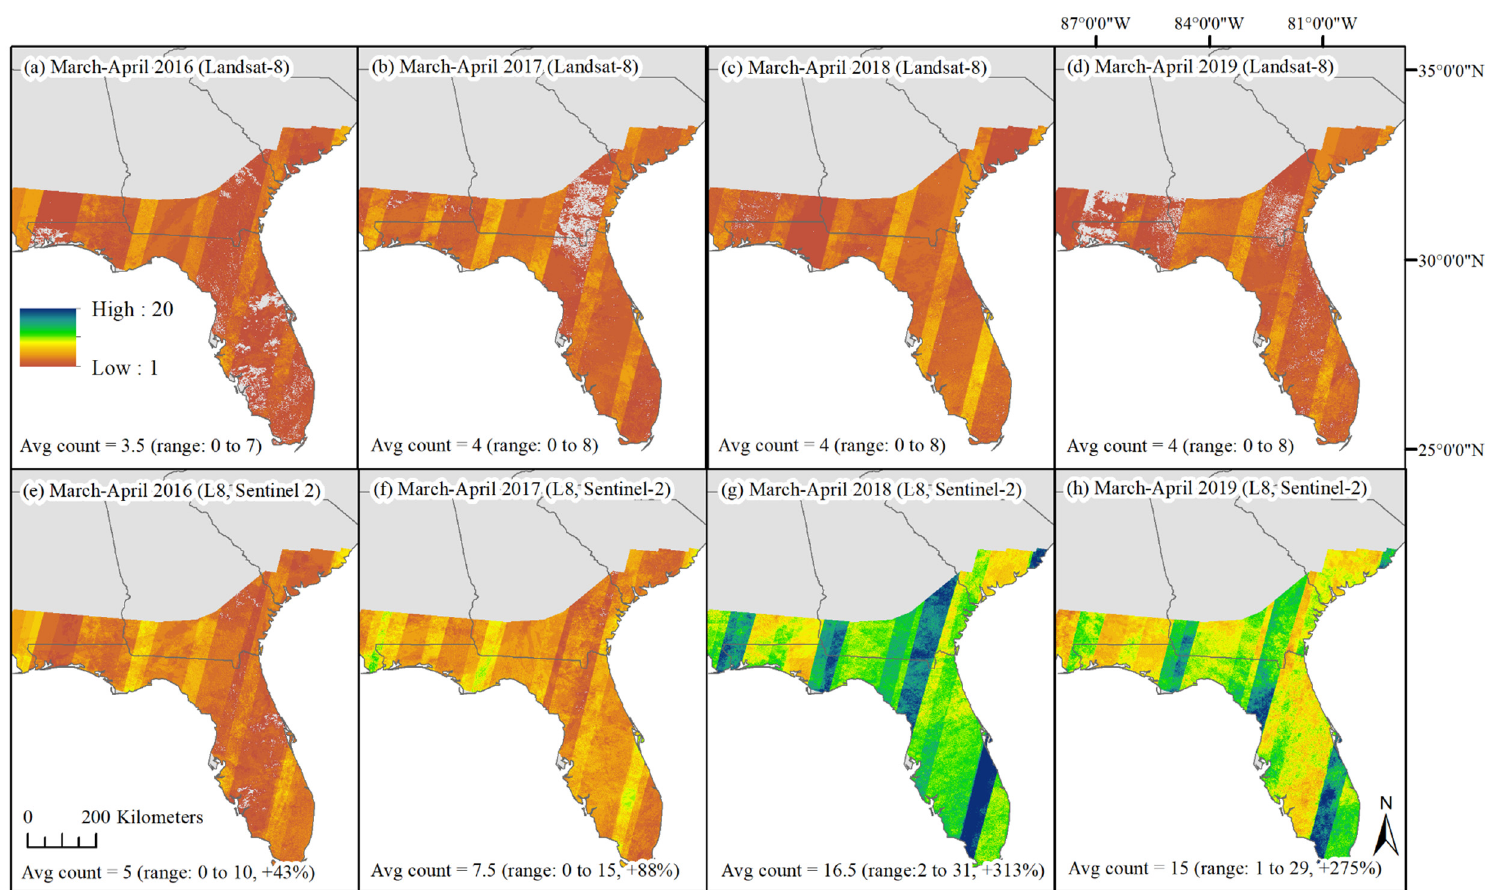
Figure 3. The number of cloud-free observations (2016–2019) using just Landsat-8 (L8) or Landsat-8 and Sentinel-2 satellites. Percentiles represent increase in the cloud-free observations when including Sentinel-2, relative to using Landsat-8, alone. Observation count for March and April was selected to represent the regional peak in wetland fire frequency. Avg = average.